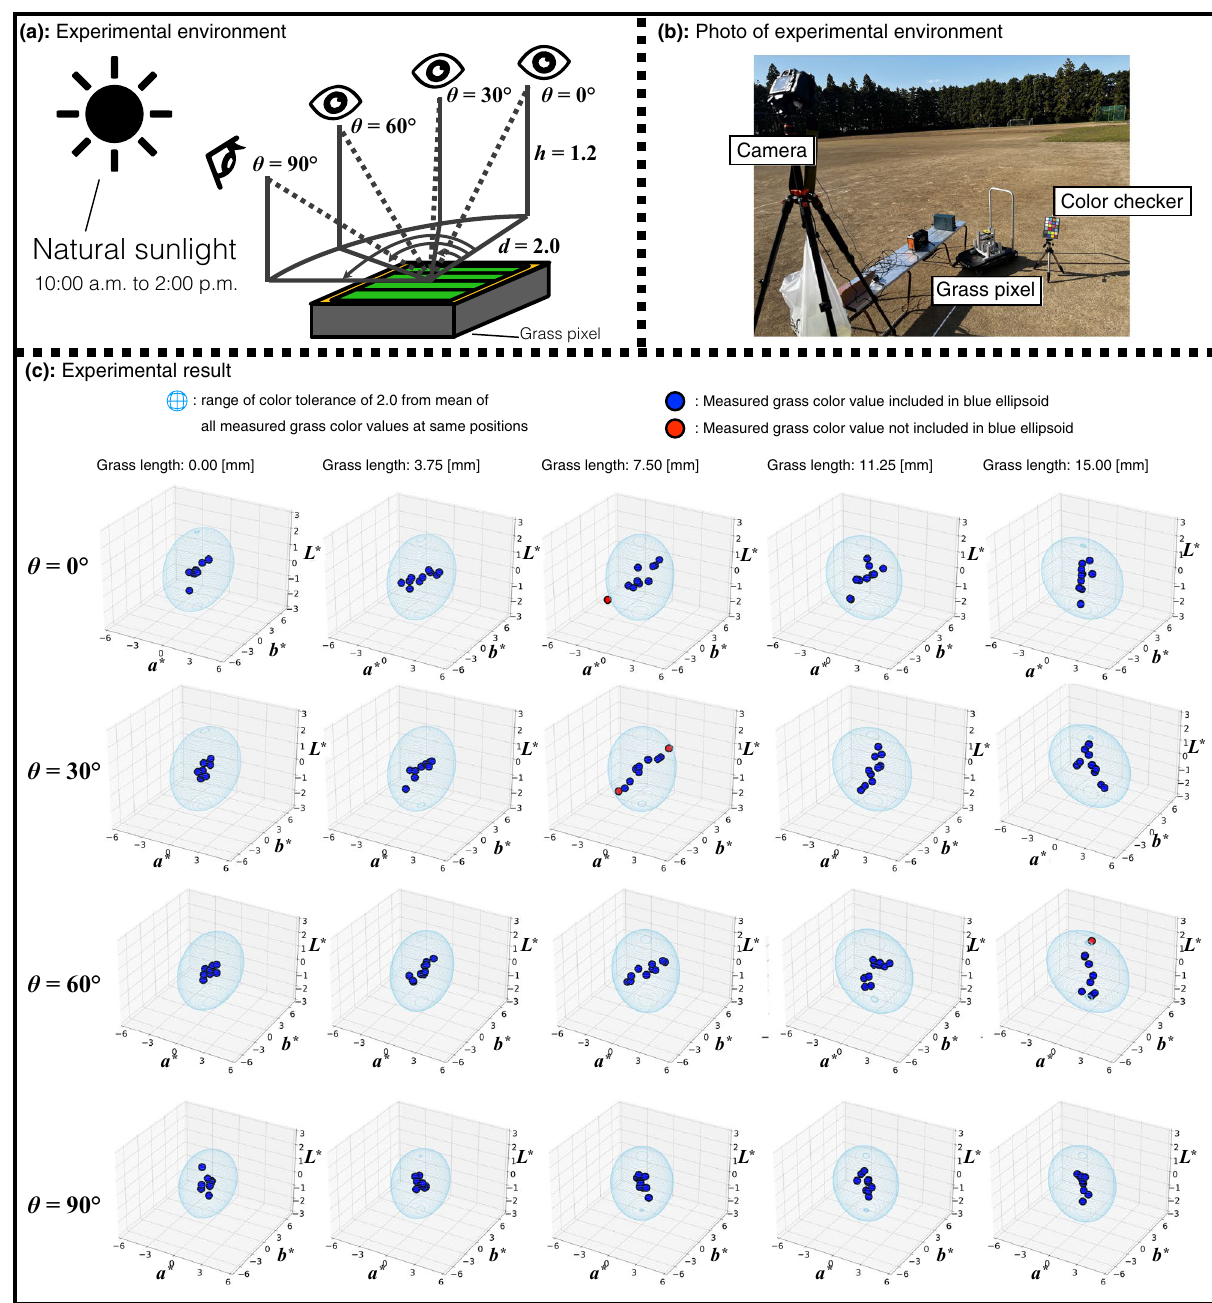
Figure 8. Simple experiments on repeatability and reliability of grass pixel. ( a , b ) The camera height and the distance between the camera and the grass pixel were fixed. The horizontal angles between them were 0 ◦ , 30 ◦ , 60 ◦ , and 90 ◦ . The experiments were conducted the playground in the University of Tsukuba under natural sunlight from 10:00 a.m. to 2:00 p.m. ( c ) Since most of the measured grass color values were within the blue ellipsoid of the color tolerance of the reference grass color value for each camera position, the experimental results revealed that the grass pixel can show the grass color stably with the grass length. This figure was created using Serif Affinity Designer version 1.10.0 (https:// affin ity. serif. com/ en- us/) and Matplotlib version 3.2.2 (https:// matpl otlib. the animations by changing the displayed images. In the demonstrations, we captured the grass animation dis- play at ( h , d , θ) = ( 1.7, 2.0, 0 ) and adopted the green grass lengths suitable for the color scale. In the grass color scale experiments at the same camera position, the measured grass color value of these green grass lengths was included within the color tolerance of 3.0 of each G n . The grass animation display played four animations, and the keyframe interval of the animation system was 1.0 [s].